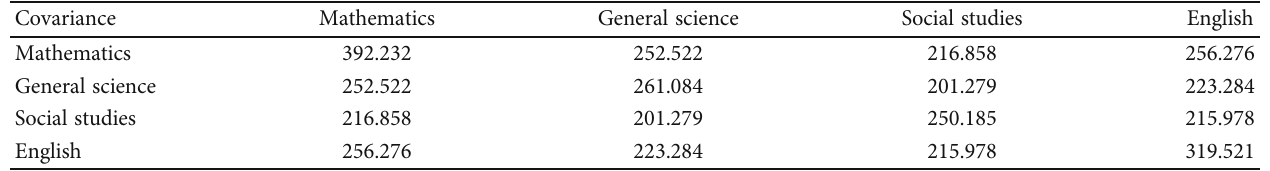
Table 15: The covariance for total nontribal girl